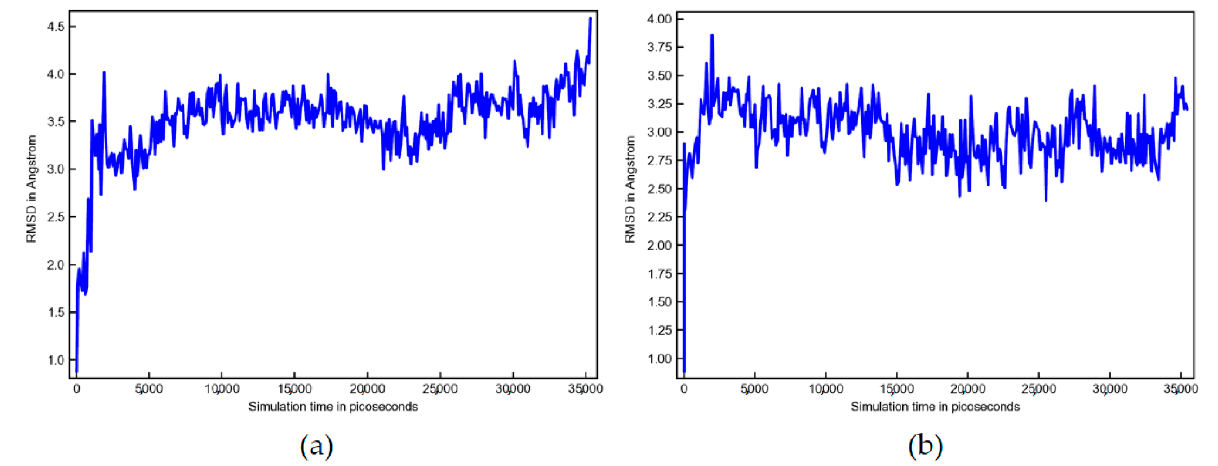
Figure 9. Root Mean Square Deviation (RMSD) graphs obtained by molecular dynamics simulation showing the variation as a function of time of both ligand movement for: ( a ) compound 6 and ( b ) GS-441524.